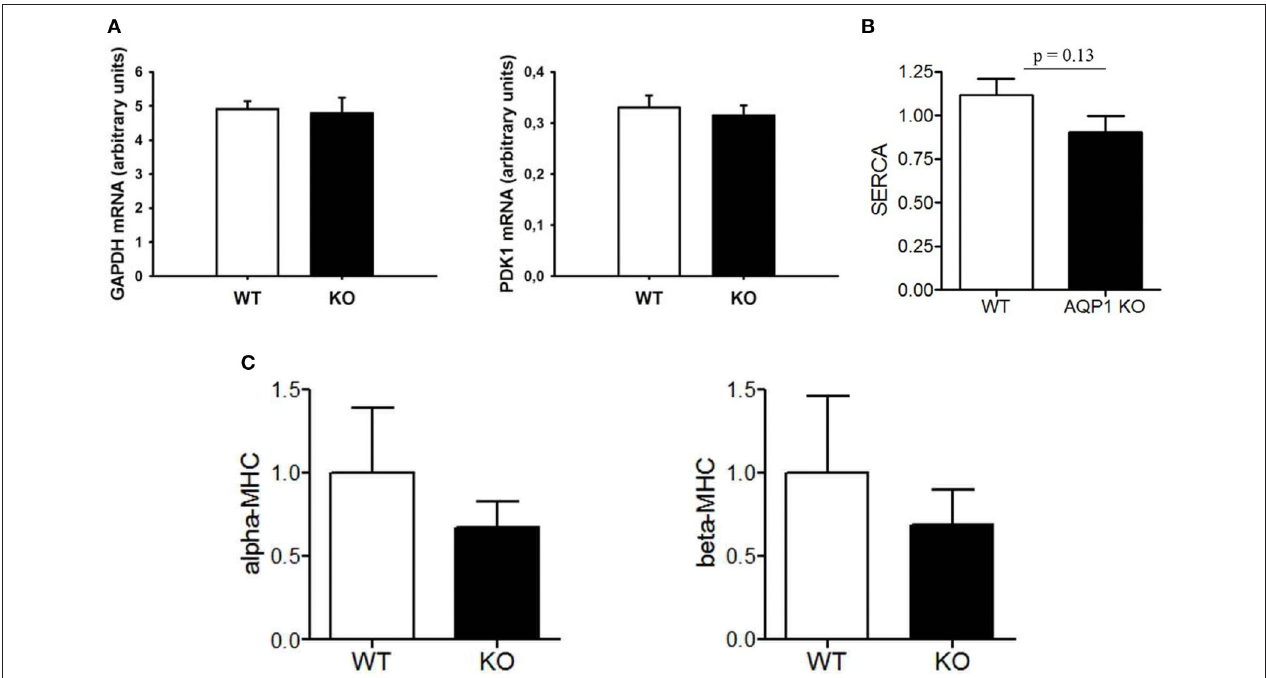
FIGURE 5 | Analyses of transcripts from LV tissue of the WT and KO mice used in PV loop measurements. (A), mRNAs from two HIF-dependent enzymes GAPDH and PDK1; (B) , sarco-endoplasmic reticulum Ca ++ -ATPase; (C) , α - and β -myosin heavy chain